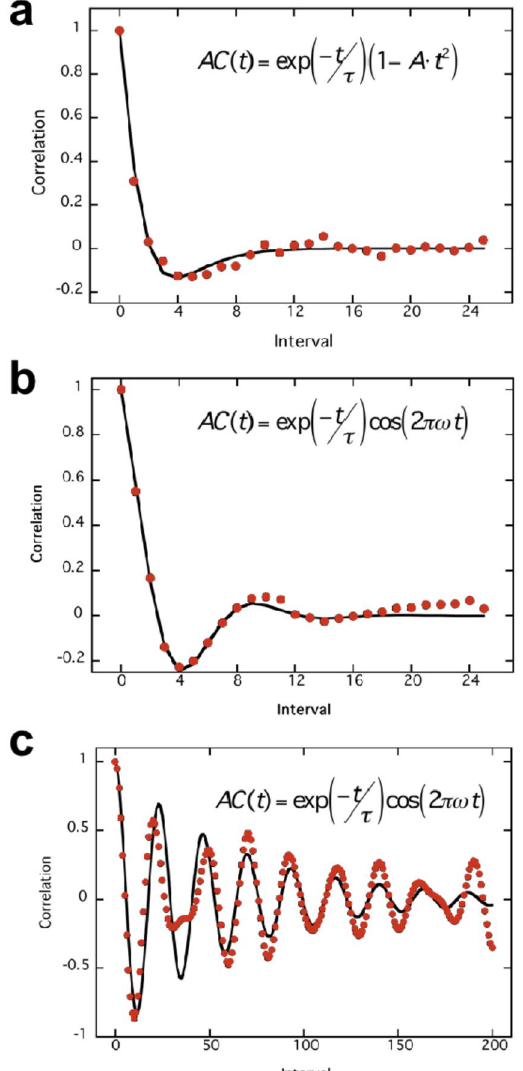
Figure 2. Click autocorrelation data as a function of offset in intervals and the best fitting equation under three conditions. ( a ) Autocorrelation function for one subject under unpredictable conditions that was best fit by Eq. (1). This equation provided the best fit for 10 subjects under unpredictable conditions. ( b ) Autocorrelation function best fit by Eq. (2), which provided the best fit to unpredictable data of 8 subjects. ( c ) Equation (2) provided the best fit to the data of all 18 subjects when clicking around an imaginary circle. Note that the abscissa extends to 200 intervals in this case, whereas it only extended to 25 intervals in ( a , b ). This reflects the very slow exponential decay of correlations in the circle condition relative to the rapid decay in the unpredictable condition. Panels (a,c) represent the subject’s data shown in Fig. 1a,b